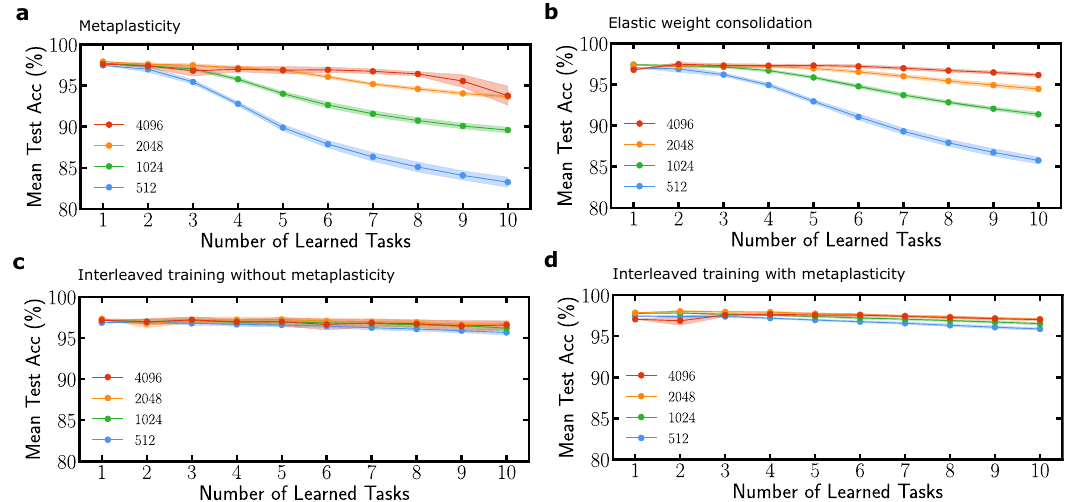
Fig. 3 In fl uence of the network size on the number of tasks learned. a , b Mean test accuracy over tasks learned so far for up to ten tasks. Each task is a permuted version of MNIST learned for 40 epochs. The binarized neural network architecture consists of two hidden layers of a variable number of hidden units ranging from 512 to 4096. a Uses metaplasticity with parameter m = 1.35 and b uses elastic weight consolidation with λ EWC = 5000. The decrease in mean test accuracy comes from the impossibility to learn new tasks because too many weights are consolidated. Results for non-sequential (interleaved) training for c a non-metaplastic and d a metaplastic binarized neural network. In this situation, each point is an independent training experiment performed on the corresponding number of tasks. All curves are averaged over fi ve runs and shadow areas denote one standard